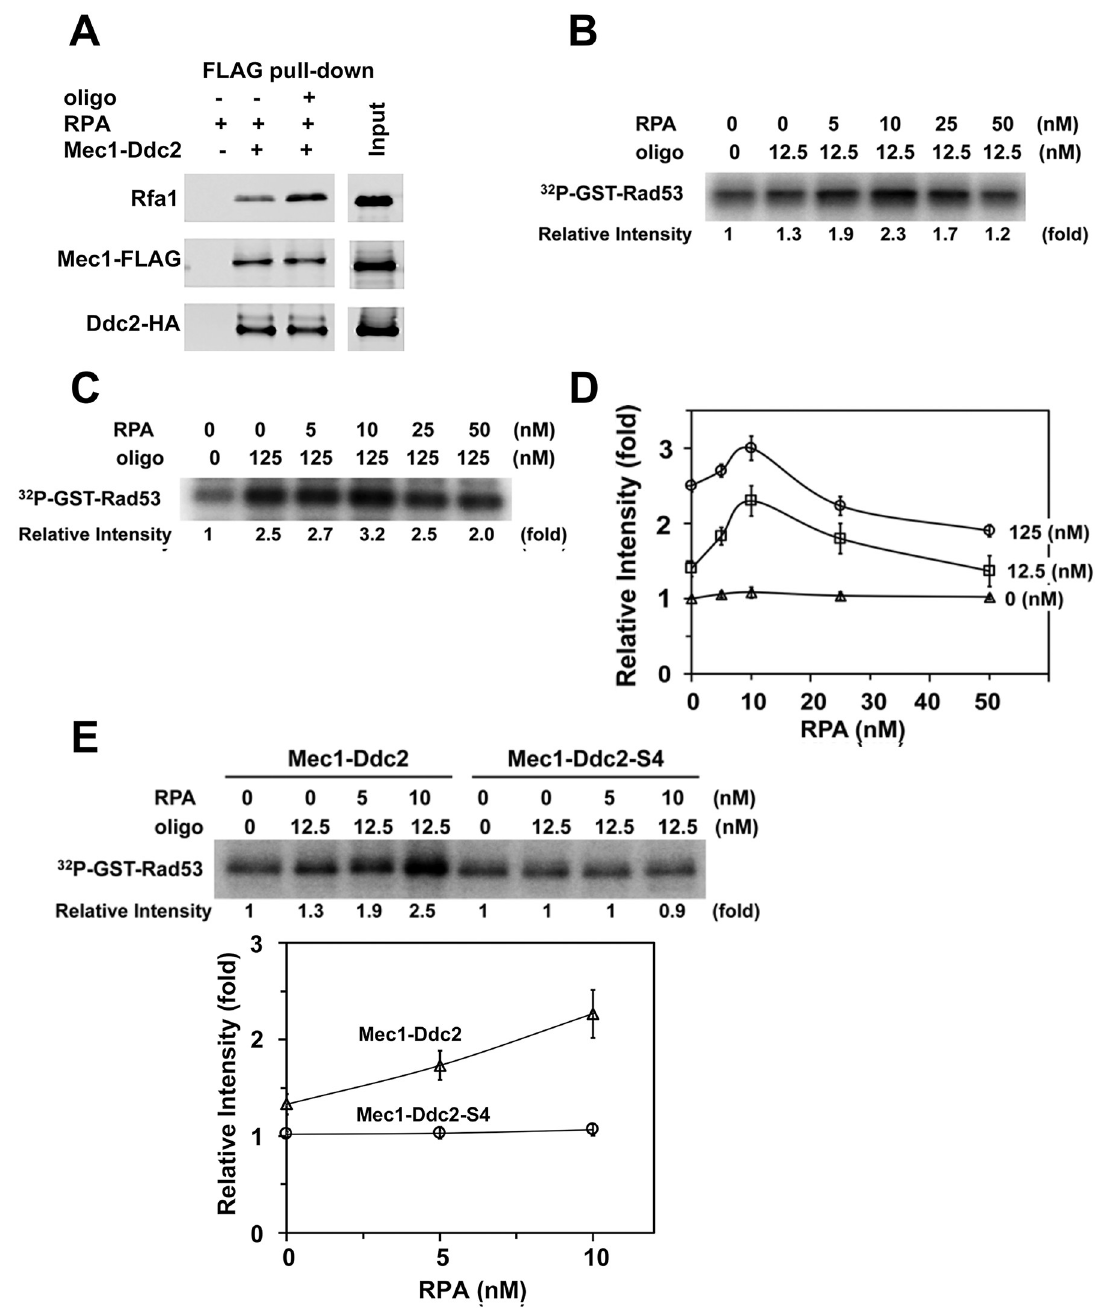
Fig 7. Effects of RPA on ssDNA-dependent Mec1 activation. (A) Interaction of Mec1-Ddc2 with RPA in the presence or absence of ssDNA. Mec1-Ddc2 (0.5 pmol) and RPA (1 pmol) were incubated with ANTI-FLAG-M2 agarose in the presence or absence of bio-oligo (dN) 80 (5 pmol). Proteins bound to ANTI-FLAG-M2 agarose were analyzed by immunoblotting analysis with anti-FLAG, anti-HA or anti-Rfa1 antibodies. Note that Mec1 is FLAG-tagged and Ddc2 is HA-tagged. (B) Effect of RPA addition on Mec1 activation in the presence of low concentrations of ssDNA. Kinase reactions were carried out with Mec1-Ddc2 (5 nM) using various concentrations of RPA in the absence or presence of bio-oligo(dN) 80 (12.5 nM). Incorporation of 32 P into GST-Rad53 was analyzed as in Fig 6A. Kinase activities of Mec1-Ddc2, normalized to that observed with Mec1-Ddc2 alone, are shown in comparison with those in the presence of RPA or ssDNA. Experiments were carried out three times and the representative result is shown. (C) Effect of RPA on Mec1 activity in the presence of high concentrations of ssDNA. Kinase reactions were carried out with Mec1-Ddc2 (5 nM) using various concentrations of RPA in the absence or presence of bio-oligo(dN) 80 (125 nM). Incorporation of 32 P into GST-Rad53 was analyzed as in Fig 6A. Kinase activities of Mec1-Ddc2, normalized to that observed with Mec1-Ddc2 alone, are shown in comparison with those in the presence of